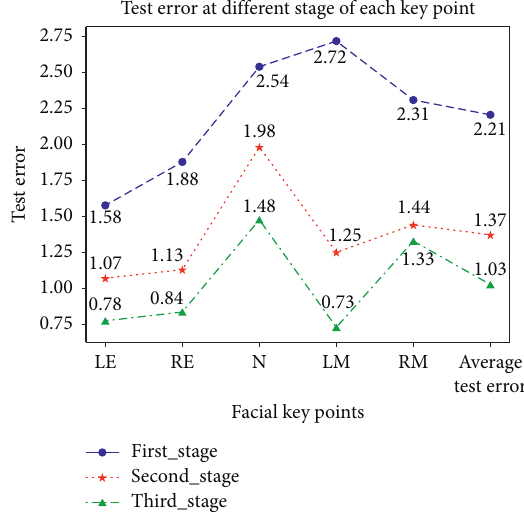
Figure 4: Test error graph of key points in different stages.